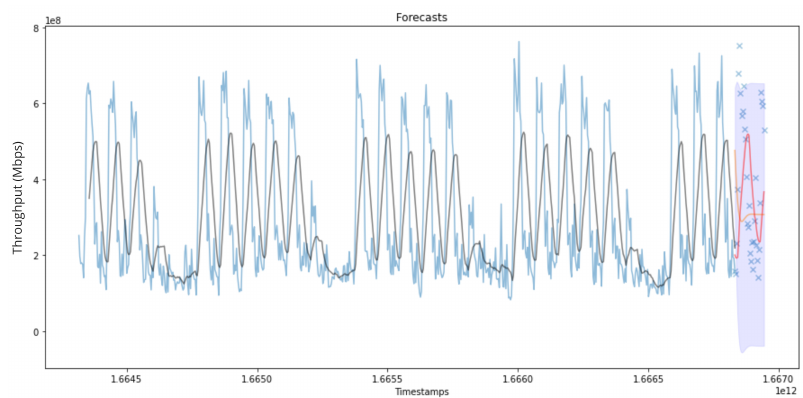
Figure 23. The throughput